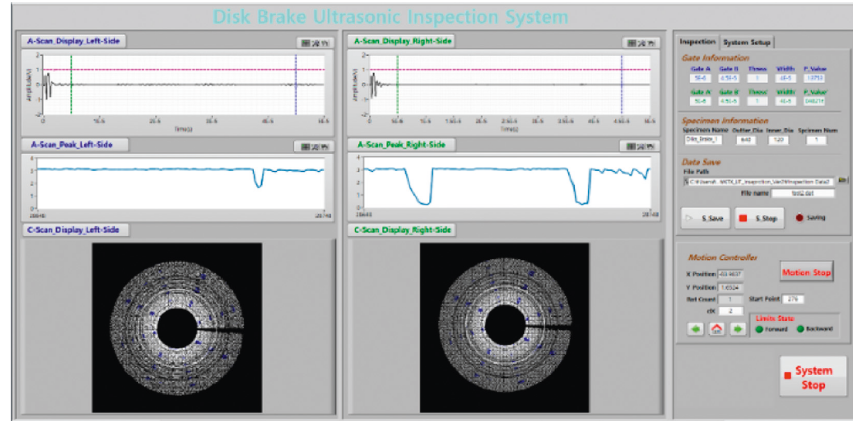
Figure 10: Ultrasonic signal acquisition software interface.